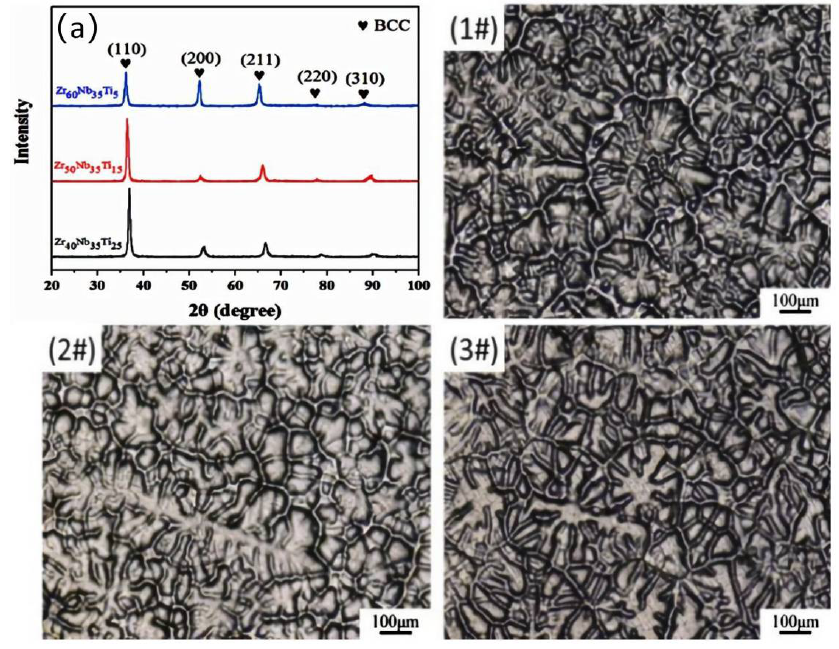
Figure 2. ( a ) XRD patterns and optical images of Zr 40 Nb 35 Ti 25 ( 1# ), Zr 50 Nb 35 Ti 15 ( 2# ), and Zr 60 Nb 35 Ti 5 ( 3# ) origin alloys.